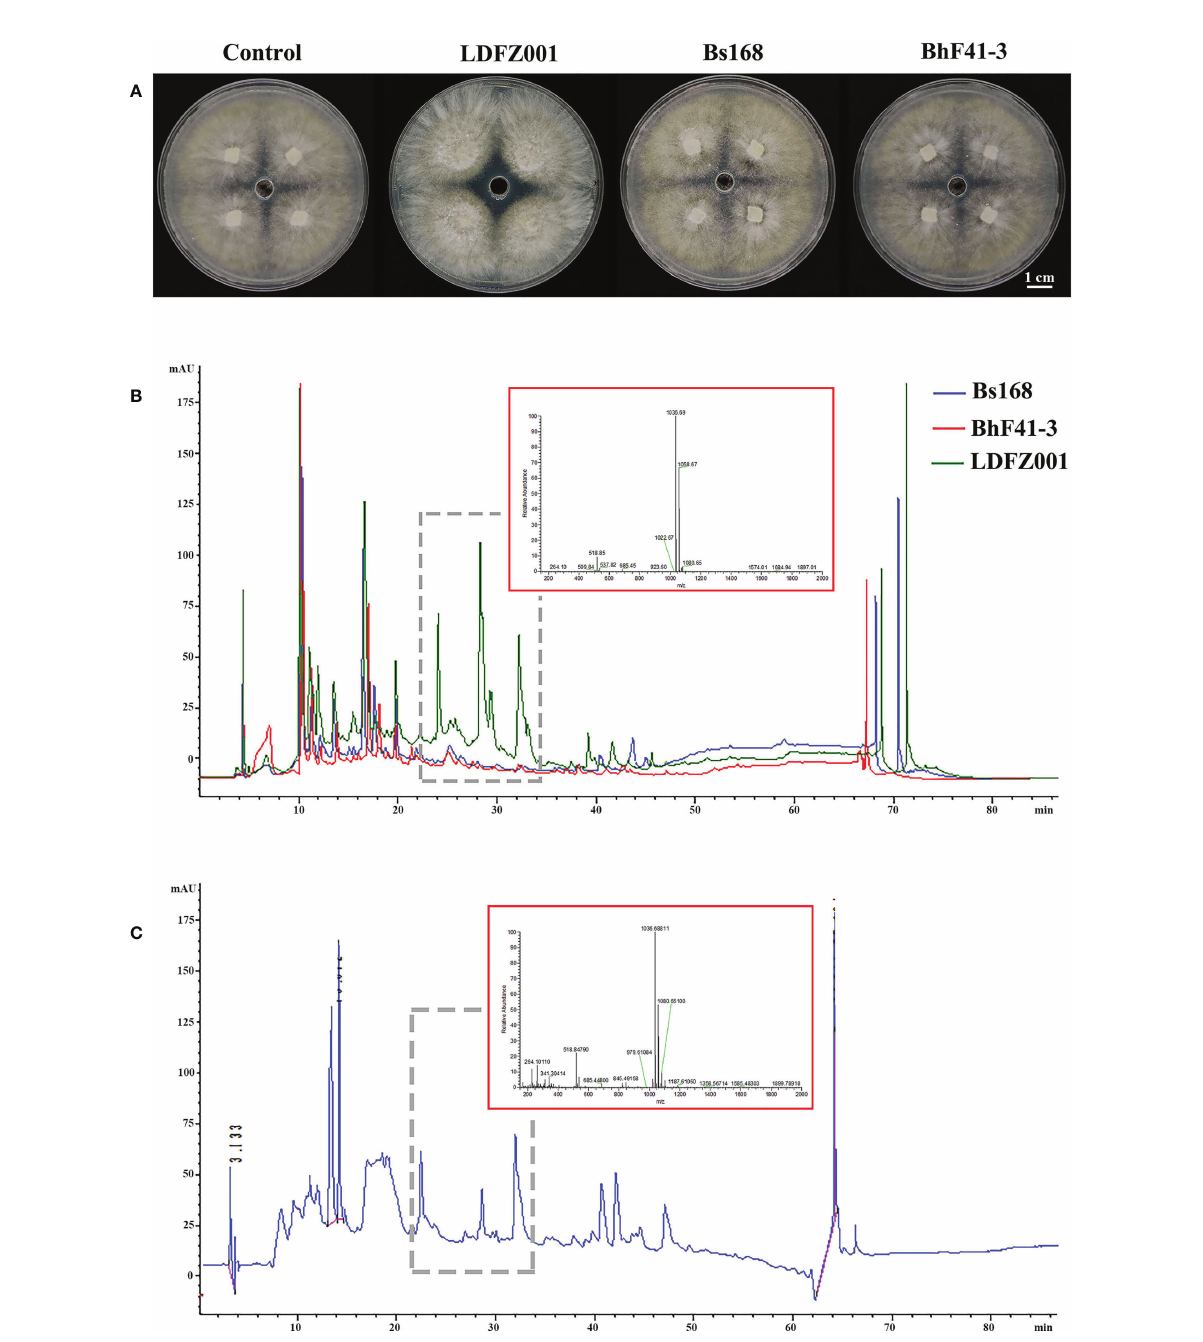
FIGURE 2 Lipopeptide extracts from B halotolerans LDFZ001 (LDFZ001), Bacillus subtillis 168 ( Bs168 ) and Bacillus halotolerans F41-3 ( BhF41-3 ) were used for antifungal activity and HPLC analyses. (A) Antifungal activity assays of putative lipopeptides against R. solani Kühn sh-1 (B, C) Pro fi ling comparisons of HPLC and the extracted ion fl ow spectra of m/z 200 – 2000 from different